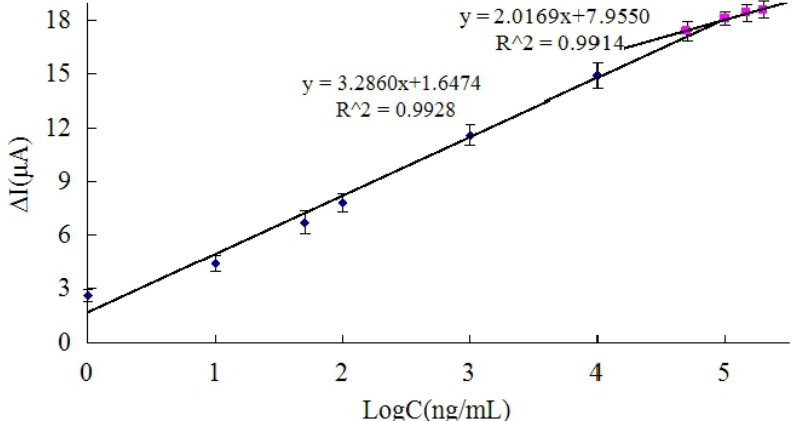
Figure 4. Calibration curve of the current response vs. the concentrations of carbofuran under optimal